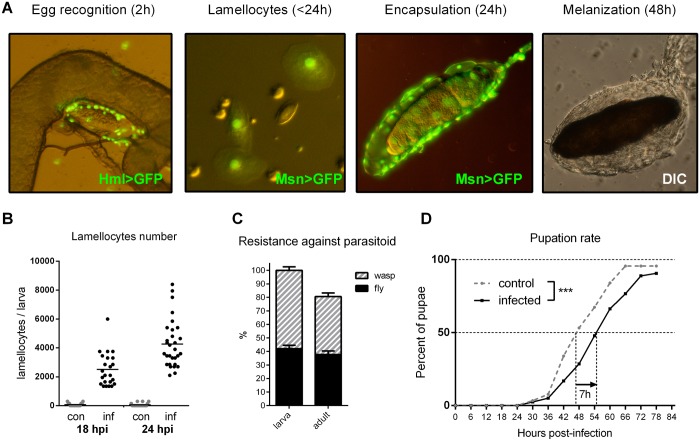
Immune response to parasitoid wasp intrusion.(A) Progressive stages of the response. The wasp egg is recognized by plasmatocytes (green, Hml>GFP) within 2 hpi. Lamellocytes, labeled by the Msn>GFP marker appear in circulation (<24 hpi) and start to encapsulate the egg. At 48 hpi, the egg is fully encapsulated by a multilayer of immune cells and melanized (original image of encapsulation published in [39]). (B) Number of lamellocytes per larva in control (con, grey) and infected (inf, black) larvae at 18 and 24 hpi. Each dot represents an individual larva; the horizontal lines indicate mean. (C) Percentage of host larvae with melanized wasp eggs (black, left column, mean 42%) and surviving host adults (black, right column, mean 38%) against winning wasp larvae and adults (hatched columns). Values are mean ± standard error of measurement (SEM). (D) Pupation of infected larvae (n = 316) was significantly delayed compared to control larvae (n = 344). Log-rank survival analysis (p < 0.0001).